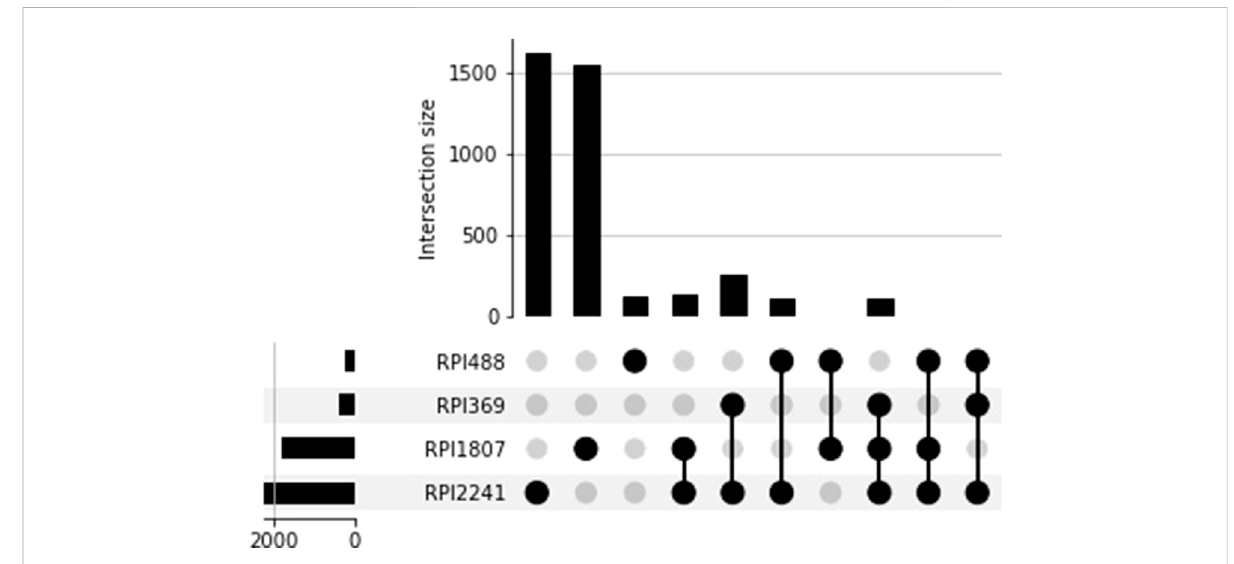
FIGURE 1 Overlap between the four RPI datasets generated from PDB RNA-protein